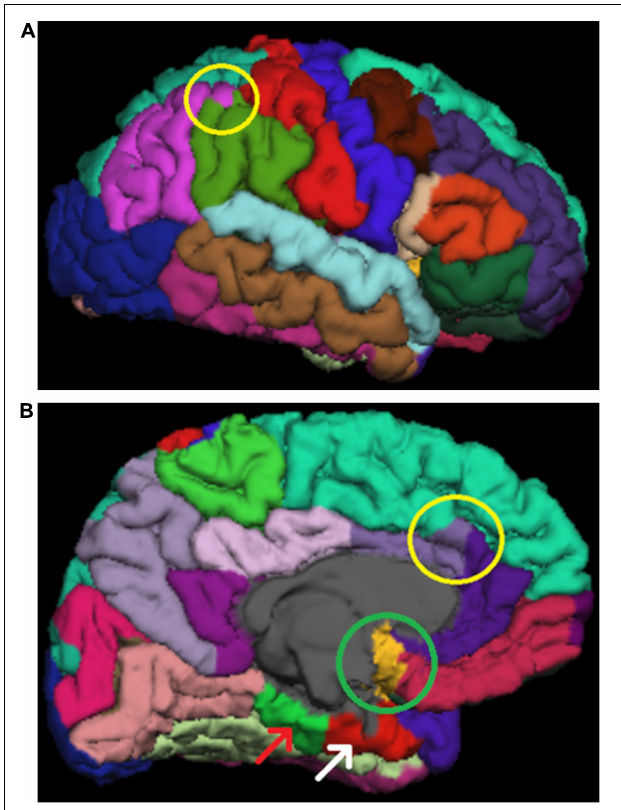
FIGURE 6 | (A) Shows an error (yellow circle) where the inferior parietal area (purple) cuts through a whole gyrus in the supramarginal region (green). This area has a lot of variation and only clear errors led to exclusion in our ENIGMA quality control protocol. (B) Shows insula overestimation in the midline (green circle). Furthermore, the poor image quality can be seen the areas adjacent to the base of the skull, such as parahippocampal (green area denoted by a red arrow) and entorhinal (red area denoted be a white arrow). Additionally, there is an error in the border between superior frontal and caudal anterior cingulate. This border should follow the sulcal line. The rostral anterior cingulate was not considered erroneous in these cases.